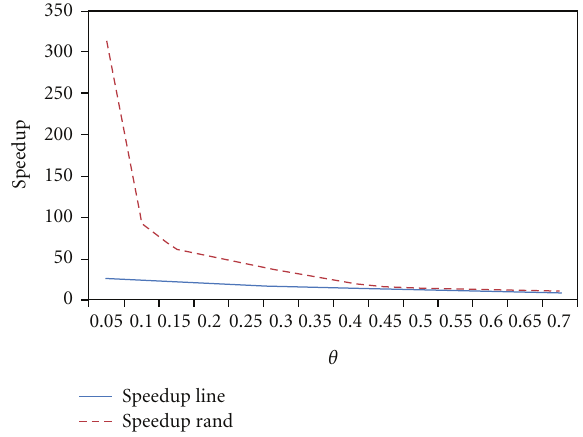
Figure 8: For lower values of theta (i.e., less approximation in Barnes-Hut), the traversal cache framework achieves larger application speedup. Higher values of theta than shown are not common in practice. N =